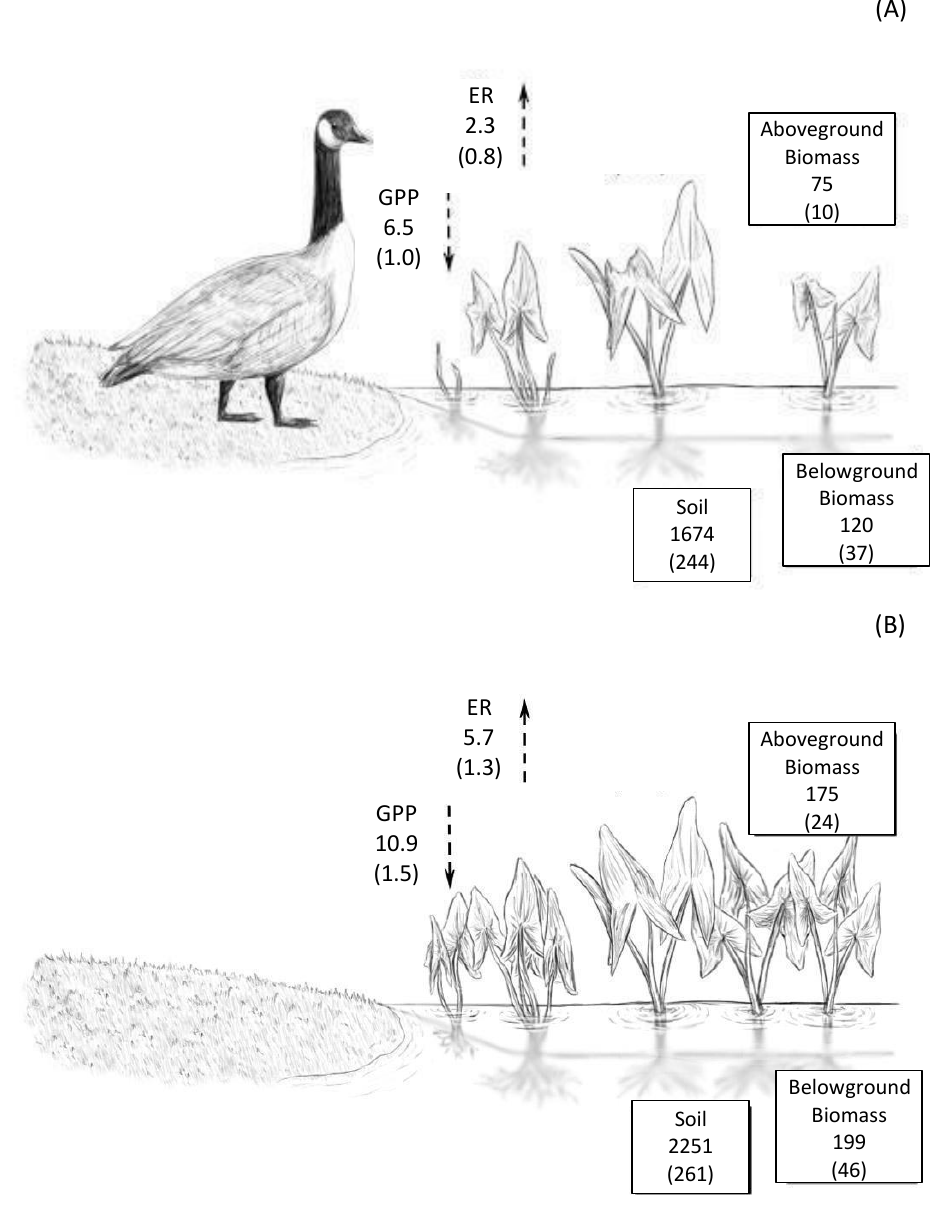
Figure 6. Estimated peak growing season carbon budget with ( A ) and after 4 years without ( B ) grazing. Average values of each variable are listed with standard error in parentheses, with values taken from caged and uncaged plots during the peak of the growing season (July) following five growing seasons of grazer exclusion (2018). Carbon pools are denoted by boxes, with units of g C m − 2 ; carbon fluxes are denoted by dashed arrows, with units of g C m − 2 day − 1